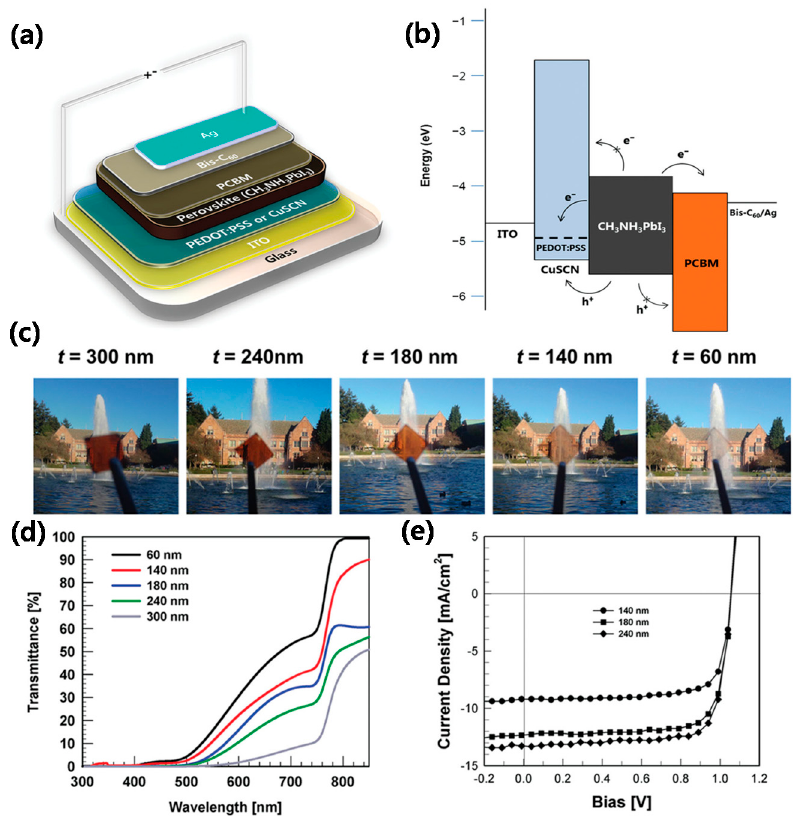
Figure 9. ( a ) Device architecture of a STPSC and ( b ) corresponding energy band diagram relative to vacuum level; ( c ) Photographs of MAPbI 3 films as a function of thickness and ( d ) UV-Vis transmittance of the corresponding films; ( e ) J - V curves of a STPSC with thin perovskite layers. Reprinted with permission from [66]. Copyright 2015 Wiley.